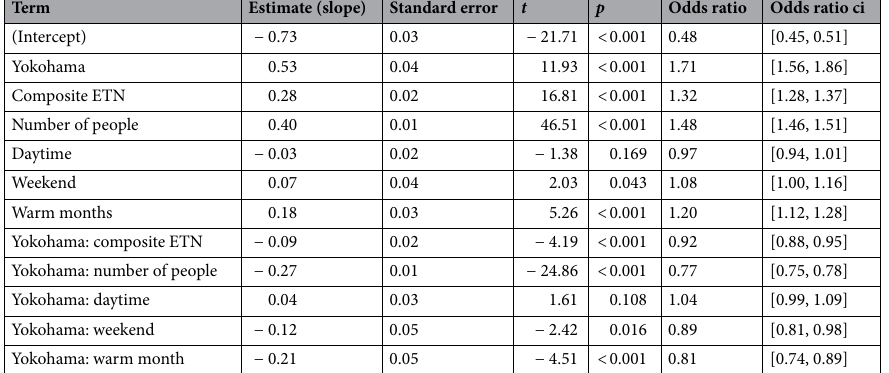
Table 2. The ETN composite association with HFE, its standard error, the test statistic ( t -value), the p -value, the odds ratio and its 95% confidence interval.